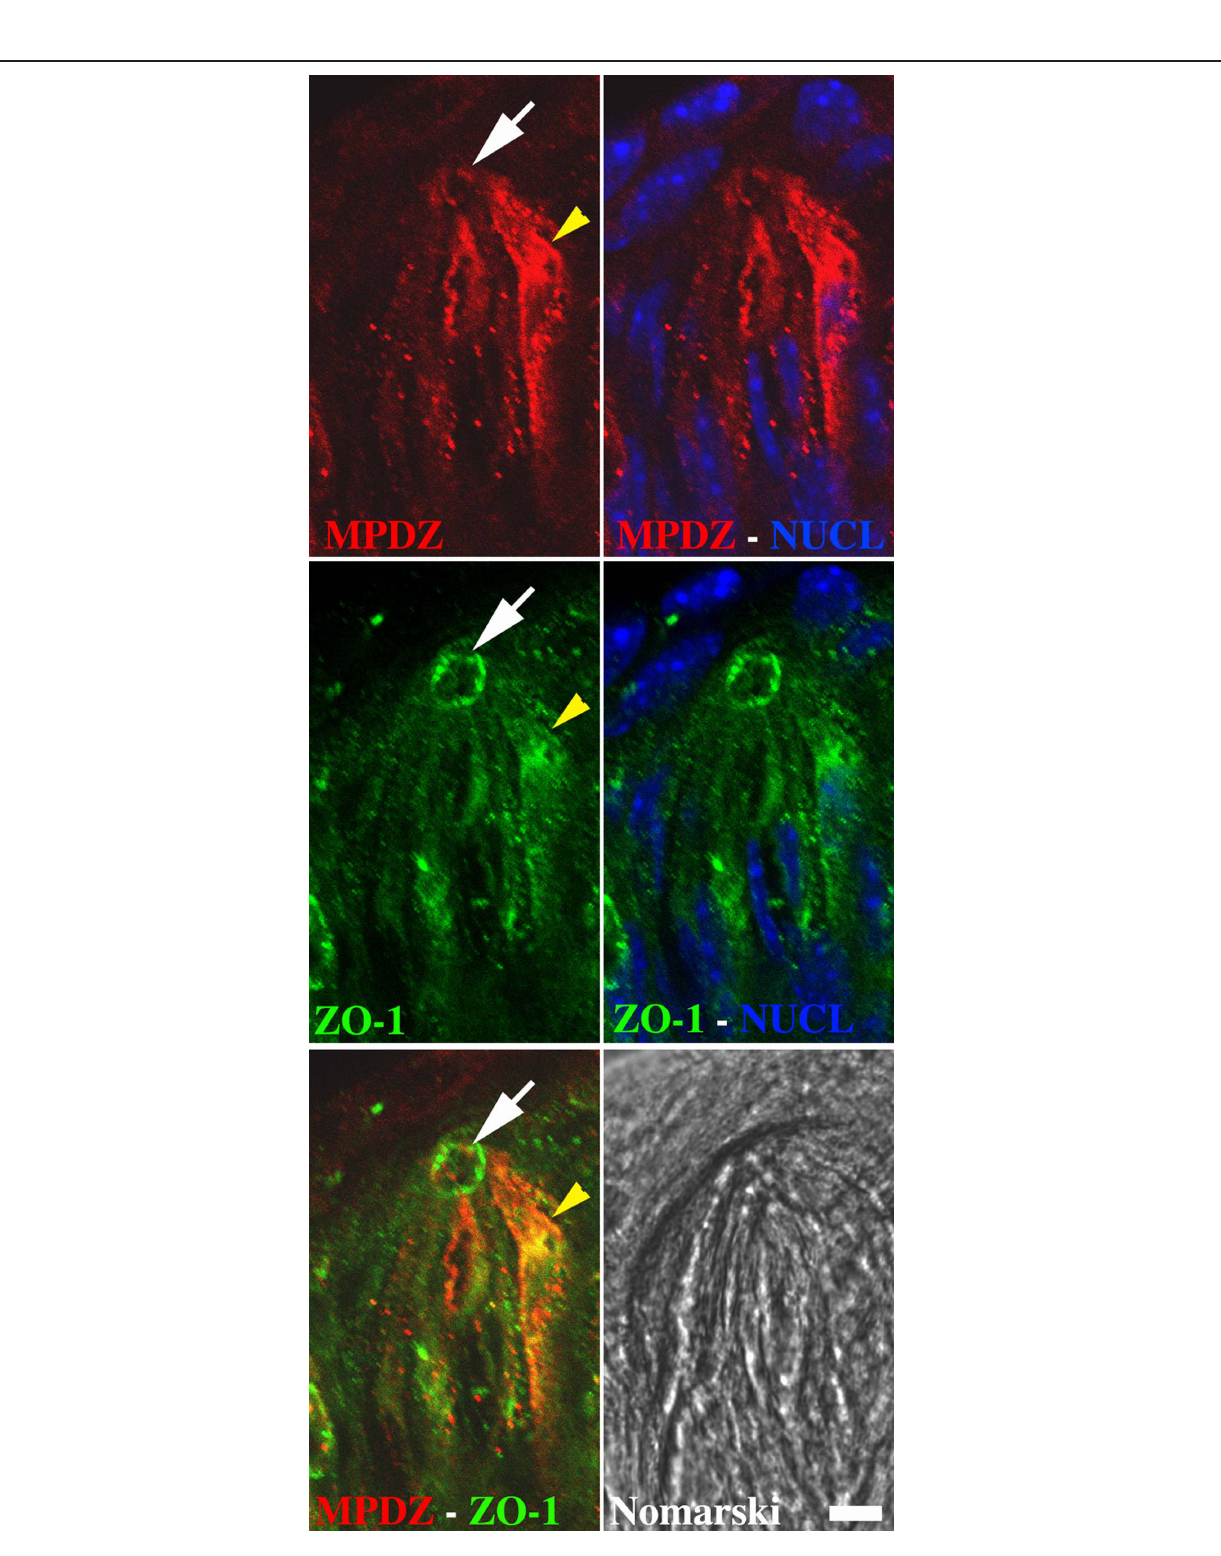
bud (apical: up, basal: down). Nuclei (blue) were visualized using nuclear stain. MPDZ and ZO-1 staining overlaps partly in the cytoplasm (yellow arrowhead) and at the taste pore (white arrow). The Nomarski image shows the location of the taste bud. Scale bar = 15 μ m. Images are representative of staining patterns from at least 5 taste